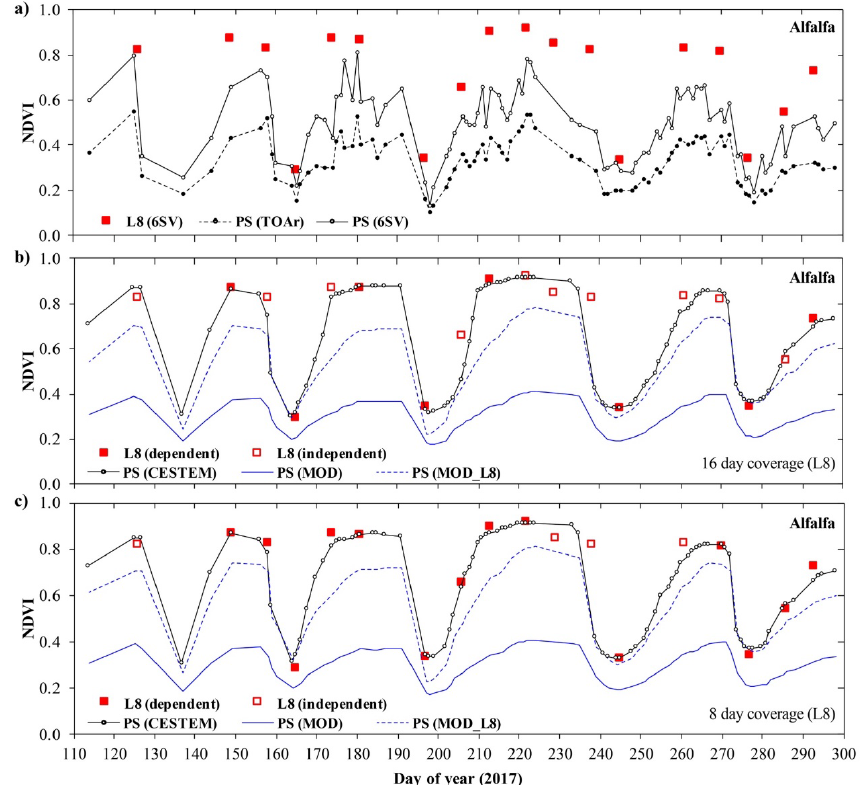
Figure 4. ( a ) Six-month time series of Landsat 8 (L8) and PlanetScope (PS) NDVI calculated from atmospherically corrected (6SV) and top of atmosphere (TOA) reflectances. The data represent an alfalfa plot unit measuring 180 × 180 m 2 (Figure 1). ( b ) CESTEM-corrected time series of PS NDVI based on 16-day L8 reference data (i.e., dependent scenes). The hollow L8 squares (i.e., independent scenes) were not used in CESTEM. The downscaled MODIS data (MOD) were used after bias correction (MOD_L8) (Section 2.4.2) to determine the relative change in surface reflectance over given CubeSat–Landsat acquisition timespans. ( c ) As in ( b ), except that reference data were drawn from the full eight-day L8